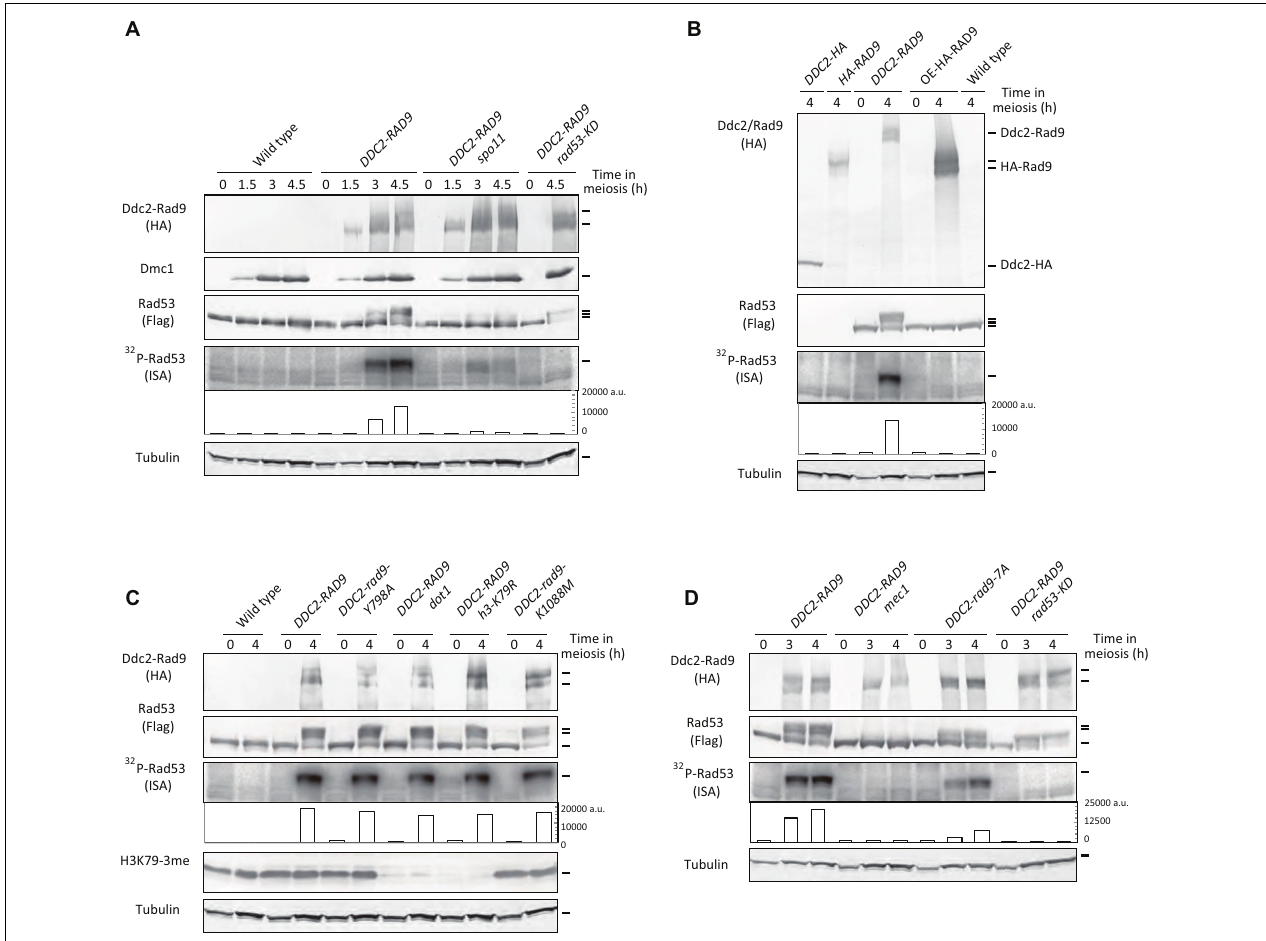
FIGURE 2 | Ddc2-Rad9 fusions activate Rad53 in meiosis. (A) TCA-precipitated meiotic cell extracts of the indicated strains were analyzed by western blotting using anti-HA, anti-Flag, anti-H3K79-3me (tri-methylation), anti-Dmc1, and anti– α -tubulin antibodies. 32 P-Rad53 represented 32 P-incorporation to Rad53 in the ISA assay, and was quantified as shown Figure 1A (fifth panels). Cell extracts derived from 4 × 10 6 cells were loaded for the ISA assay. Wild-type (USY543/544), DDC2-RAD9 (USY544/661), DDC2-RAD9 spo11 (USY783/414), and DDC2-RAD9 rad53-KD (USY545/720) were examined. (B) Cell extracts were prepared from the